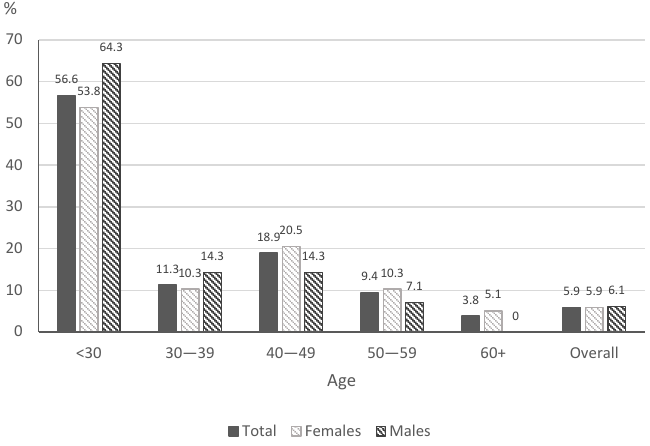
Figure 2. The prevalence of daily use of e-cigarettes.